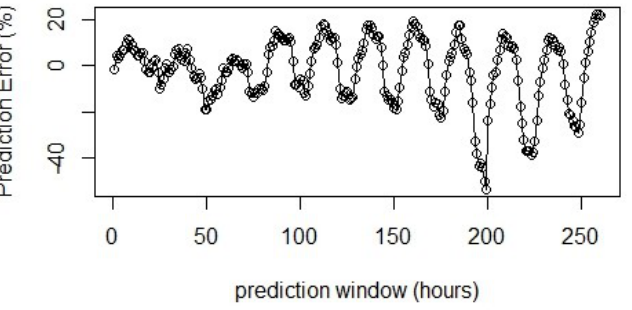
Figure 5. Prediction error by varying prediction window size from 1 h to 260 h.